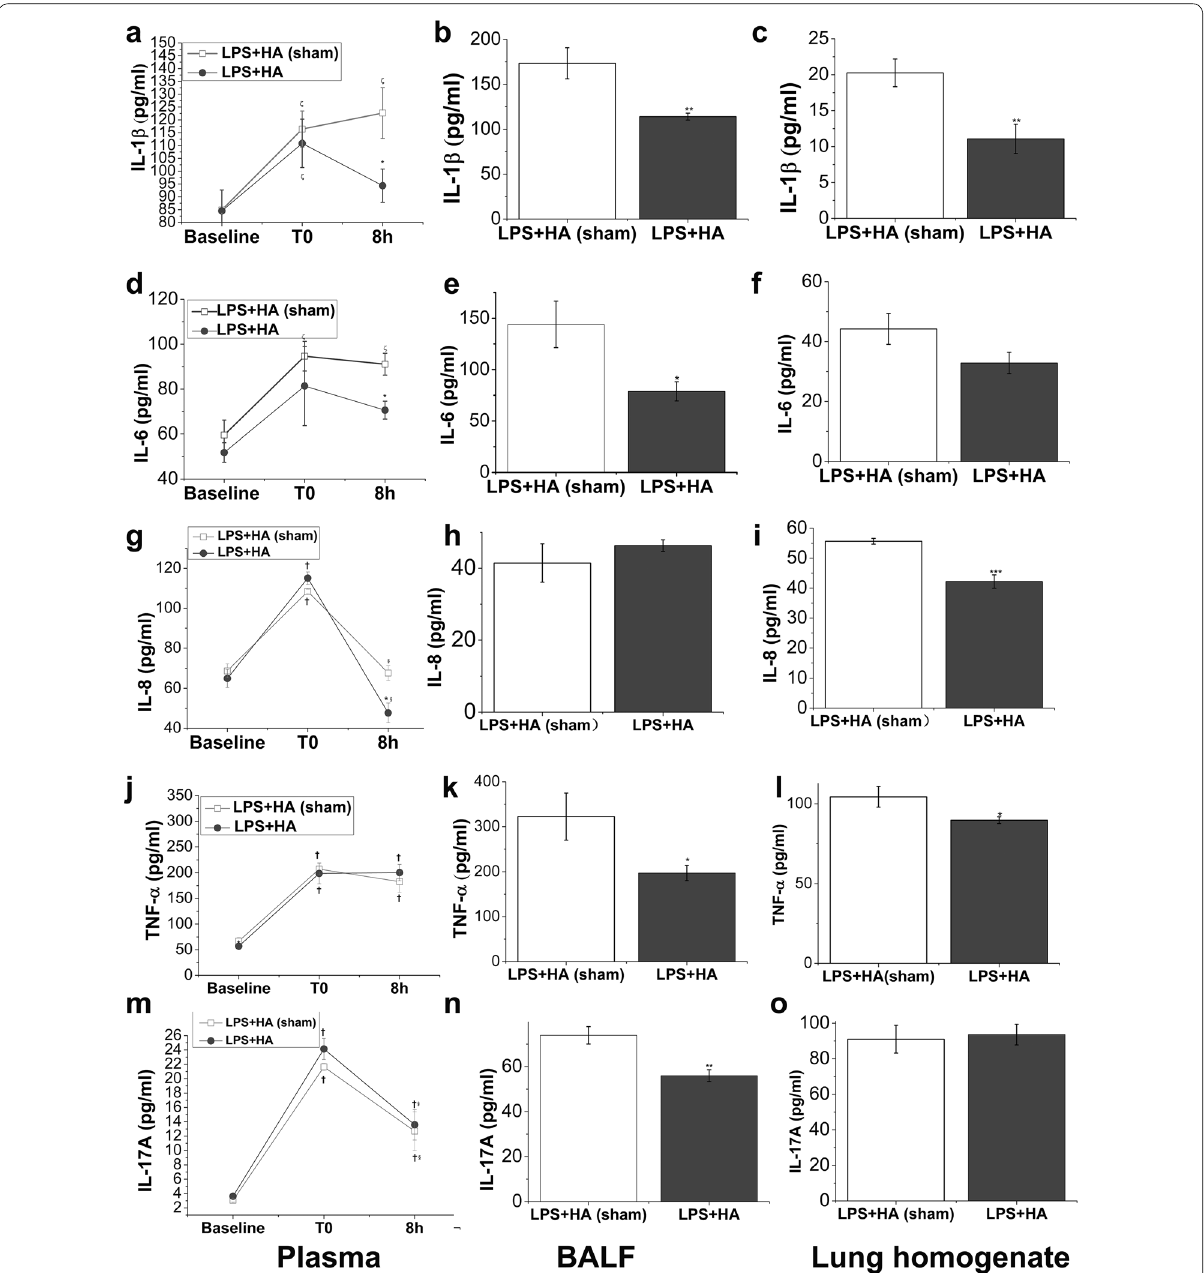
Fig. 4 Effect of HA on the production of LPS-induced circulating and pulmonary inflammatory cytokines. Pigs were allocated into LPS and LPS HA groups. Plasma was collected at baseline, and at the time point when ALI model was diagnosed (T0) and the end of the experiment + schedule (8 h after T0). BALF and lung homogenates were prepared after pigs were euthanized. The systemic and pulmonary cytokine levels of IL-1β ( a – c ), IL-6 ( d – f ), IL-8 ( g – i ), TNF-α ( j – l ) and IL-17A ( m – o ) were detected by using ELISA kits. Values are mean ** P < 0.01; *** P < 0.001 when compared between LPS compared within each